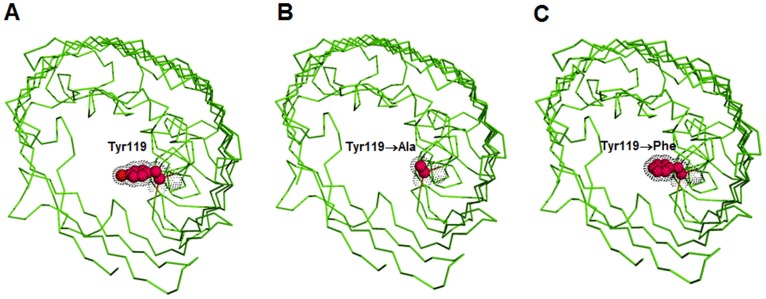
A ribbon representation of the homology model of BpsOmp38.The modeled structure of BpsOmp38WT (A) shows the key residue Y119 (red) protruding into the channel lumen (top view). This residue was mutated to Ala or Phe, generating two single mutants, BpsOmp38Y119A (B) and BpsOmp38Y119F (C).